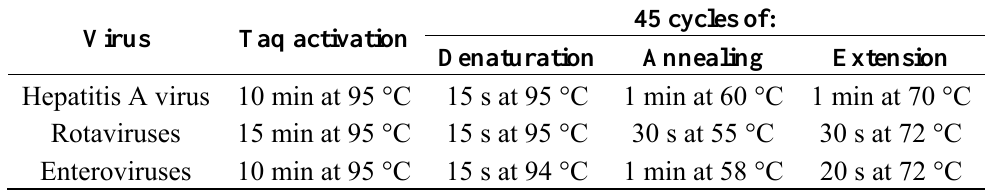
Table 2. The thermal cycling protocols for qPCR, using cDNA of the respective RNA